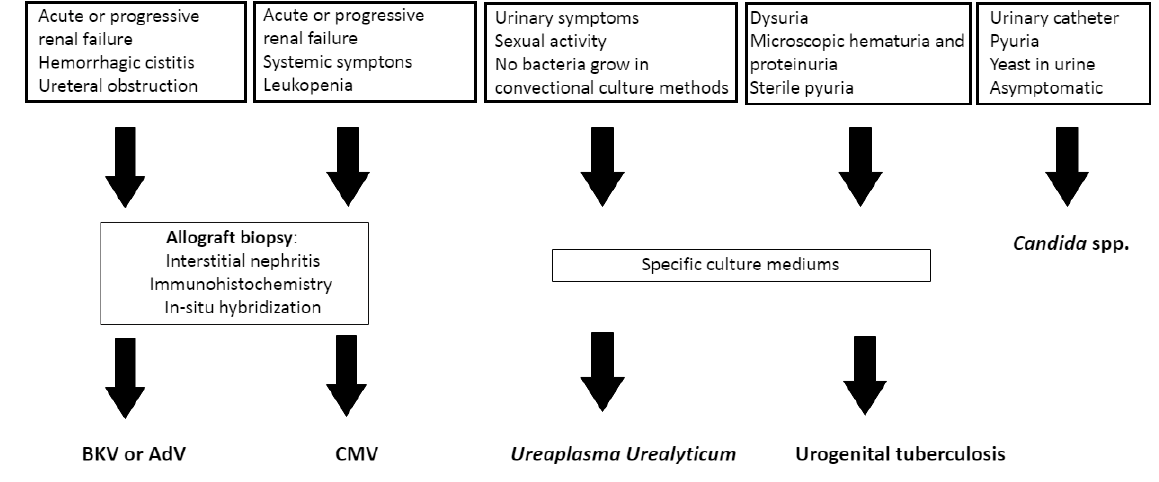
Figure 2. Diagnosis of atypical urinary tract infection.